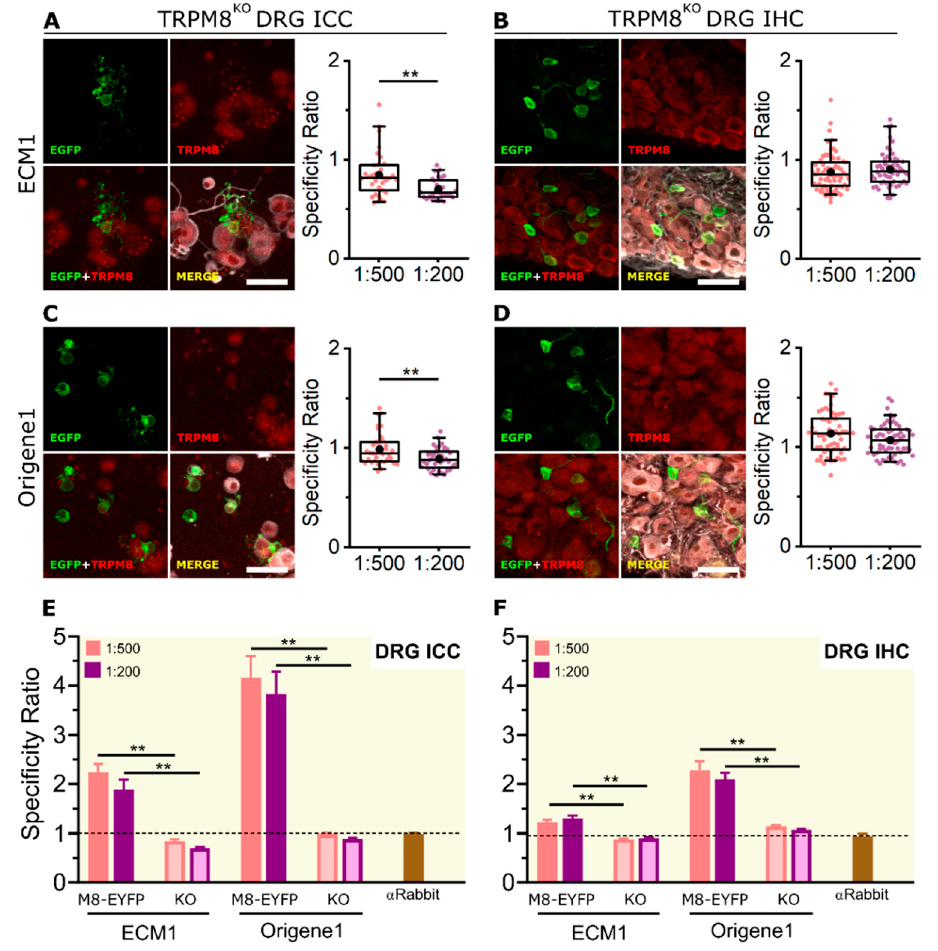
Figure 7. Immunofluorescence of endogenous TRPM8 in DRG cells and slices from the TRPM8 KO mouse. ( A , C ) Immunocytochemistry. ( B , D ) Immunohistochemistry. ( A – D left) Confocal images of TRPM8 KO ( Trpm8 EGFPf ; B6;129S1(FVB)- Trpm8 tm1Apat /J) sensory neurons. EGFP (green), TRPM8 antibody (red) and β III-Tubulin (grey). Scale bar: 50 µm. ( A – D right) Box plots represent specificity ratio (SR) for each dilution of the respective antibody. Each dot corresponds to an individual EGFP+ cell. Box contains the 25th to 75th percentiles. Whiskers mark the 5th and 95th percentiles. The line inside the box denotes the median and the black dot represents the mean (** p < 0.01, Mann–Whitney test). ( E,F ) Bar histograms summarizing the SR mean ± SEM of each TRPM8 antibody in the KO and the reporter ( Trpm8 BAC -EYFP + , named M8-EYFP in the figure) mouse in ICC ( E ) and IHC ( F ). Dashed line indicates mean SR for the control without primary antibody (** p < 0.01, Mann–Whitney test). n = at least 22 cells; 4 pictures from 2 mice for each antibody and dilution.